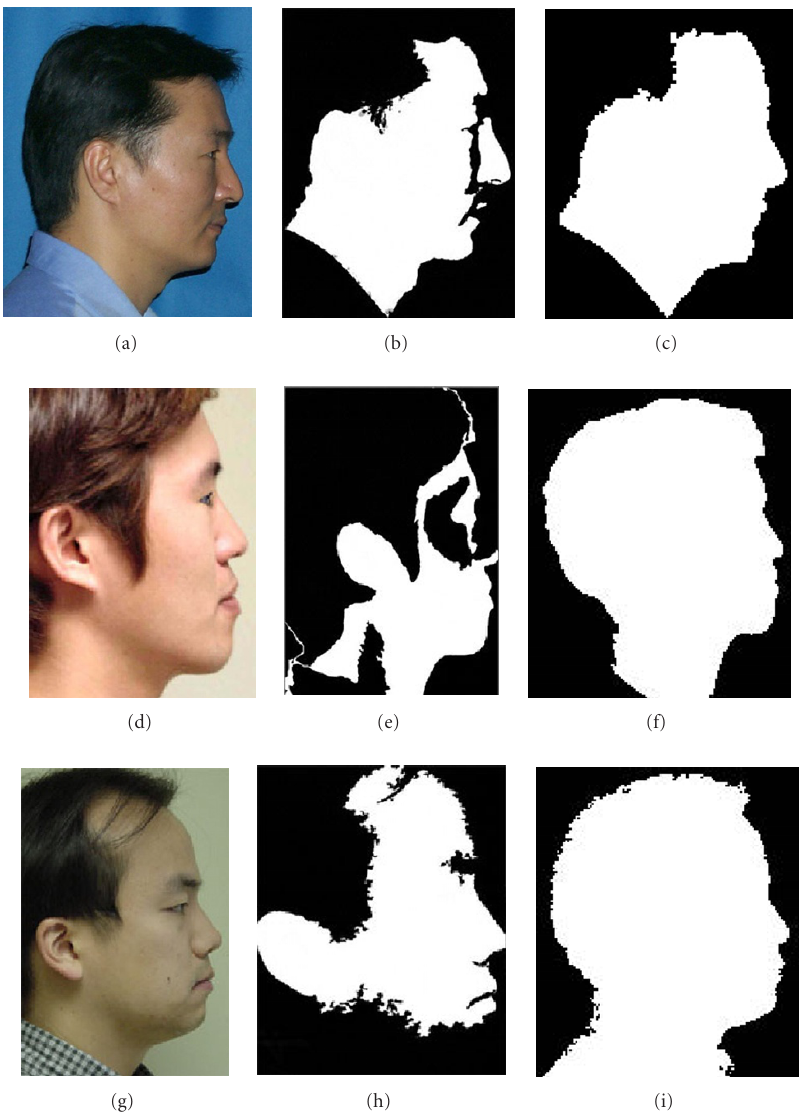
Figure 9: Failure cases of color-based segmentation and the corrected results by area segmentation. (a), (b), and (c) The case of separate skin and nose. (d), (e), and (f) The case of incomplete nose area. (g), (h), and (i) The case of incomplete chin area. (a), (d), and (g) Input images. (b), (e), and (h) The results of color-based segmentation. (c), (f), and (i) The results of area